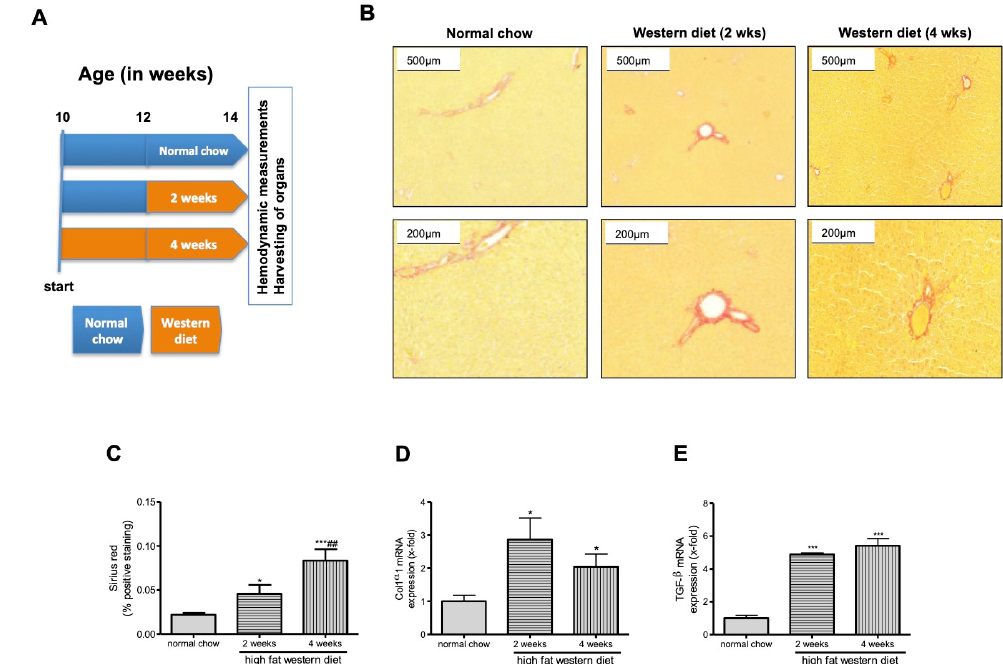
Figure 1. Fibrosis in transgenic TGR(mREN2)27 rats after high fat Western diet. ( A ) Ten-week-old rats received either normal chow for 4 weeks, or normal chow for 2 weeks followed by Western diet for 2 weeks or Western diet for 4 weeks before hemodynamic measurements and harvesting of the organs. ( B ) Hepatic Sirius Red staining show more collagen deposition in TGR(mREN2)27 rats receiving WD compared to normal chow. ( C ) The densitometric analysis of ( A ) shows an increase of collagen positive areas after 2 and 4 weeks of WD feeding. ( D ). Collagen 1 α 1 (Col1 α 1) mRNA expression quantified by RT-qPCR is increased in livers of TGR(mREN2)27 rats after 2 weeks of WD. After 4 weeks, a decrease in Col1 α 1 levels are noticed, still being higher compared to rats receiving normal chow. ( E ) Livers of TGR(mREN2)27 rats receiving 2 or 4 weeks of WD express significantly more tumor growth factor- β (TGF- β ) than TGR(mREN2)27 rats fed with normal chow. * / *** p < 0.05 / 0.01 vs. normal chow, ## p < 0.01 vs. 2 weeks high fat Western diet.